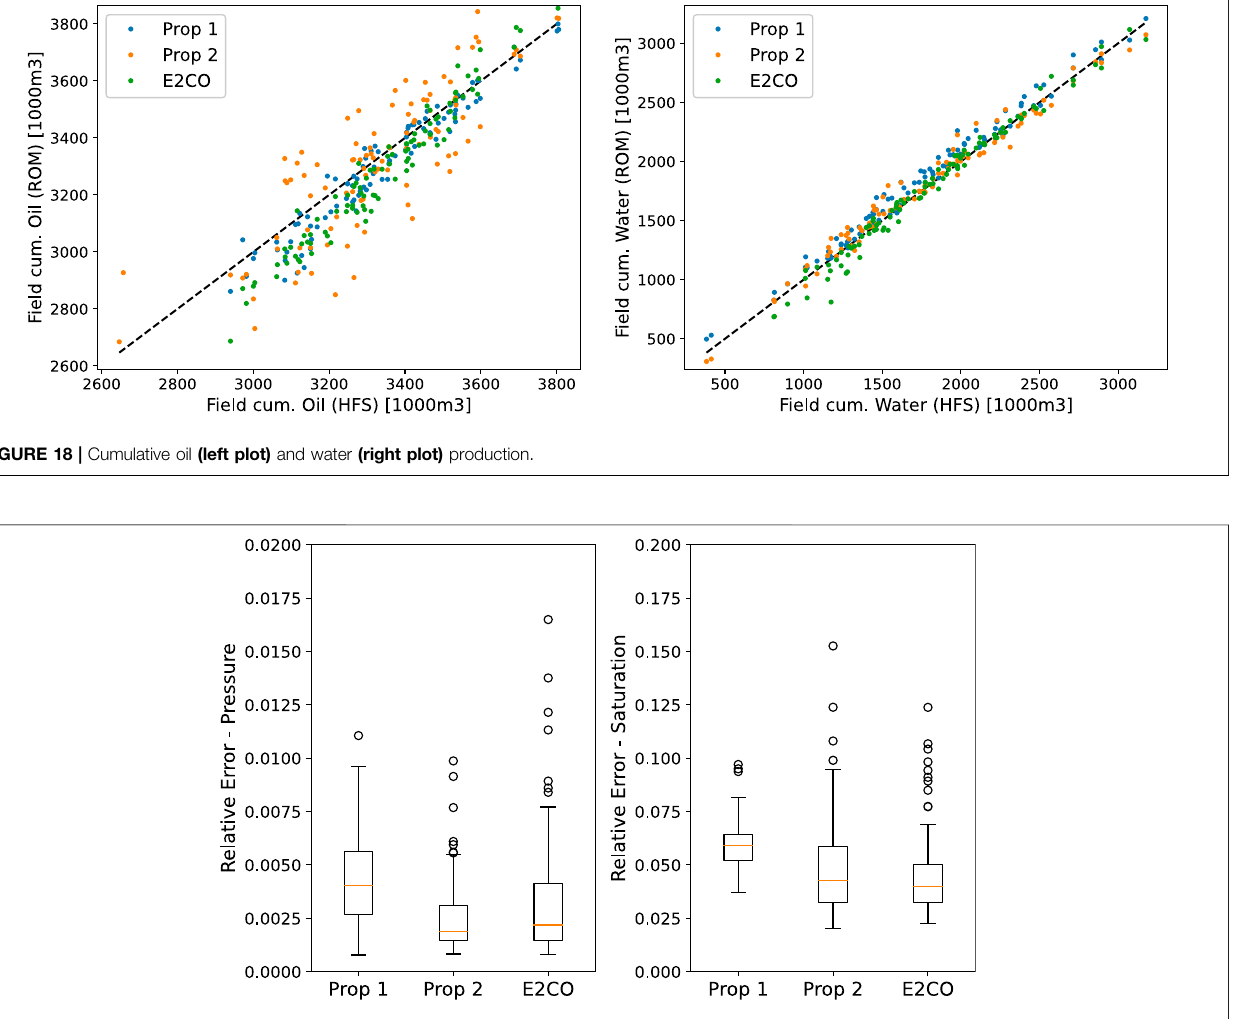
FIGURE 19 | Validation set error on the 3 propositions for pressure (left plot) and saturation (right plot) .